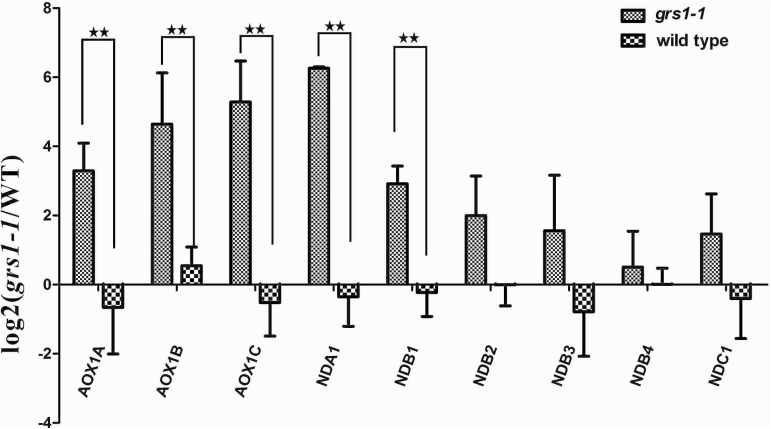
The alternative respiratory pathway is activated in grs1-1. The expression levels of alternative respiratory pathway genes in grs1-1 increased signiﬁcantly relative to the wild-type. These genes include three alternative oxidases (AOXs) and six alternative NAD(P)H dehydrogenases (NDs). The values obtained were averaged for three independent experiments, with error bars representing SD. Statistically significant differences between grs1-1 and the wild-type are indicated: **P<0.01 (Student’s t-test;).